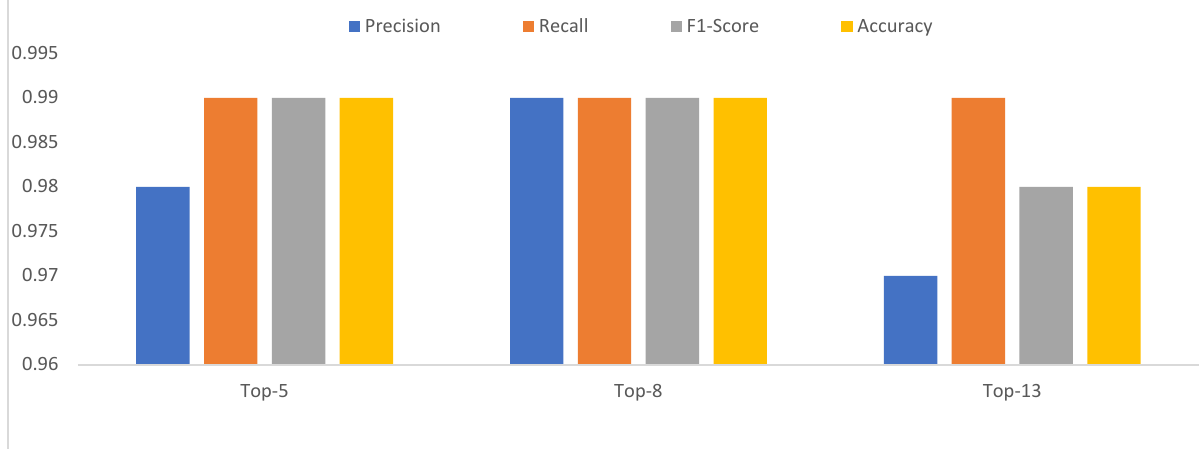
Table 5. Confusion matrix of top ‐ 5 classes.